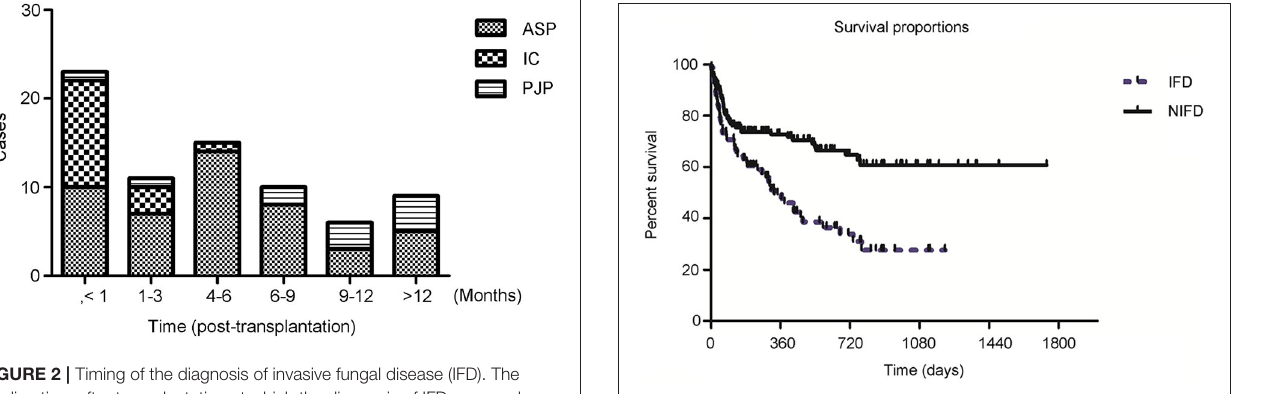
FIGURE 3 | Survival curves for lung transplant recipients in the invasive fungal disease (IFD) and non-IFD (NIFD) groups. One-year mortality was 47.6% in the IFD group and 25.2% in the NIFD group ( P < 0.001).